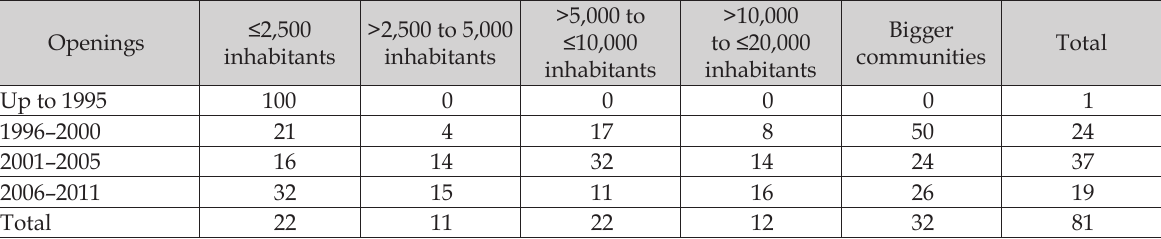
Table 4. lidl openings based on community